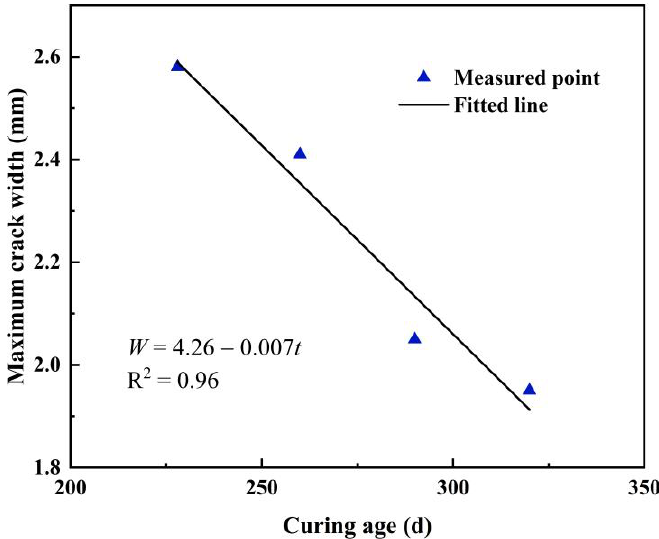
Figure 15. Maximum crack width curve after creep.